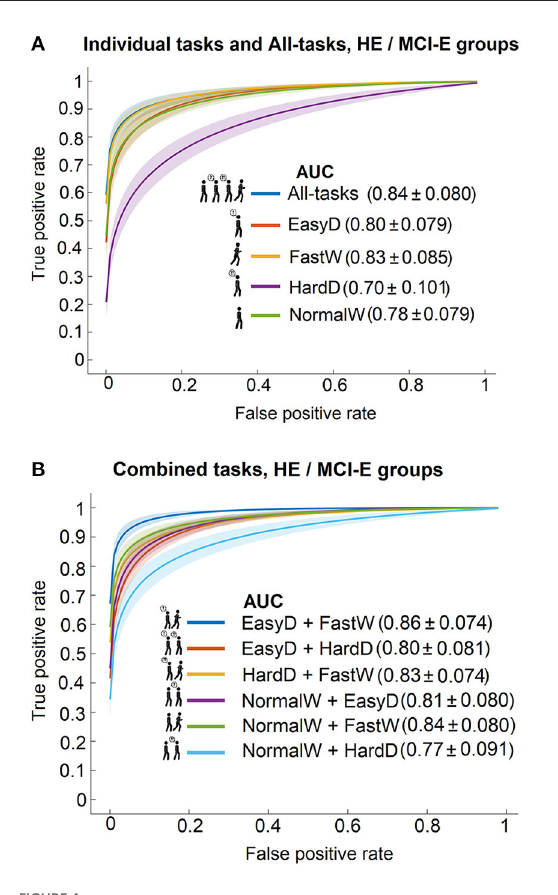
FIGURE4 ROC curves with 95% confidence bands and model AUC values for predicting the cognitive status between HE and MCI-E groups using (A) the individual tasks and the complete set, and (B) the combined tasks